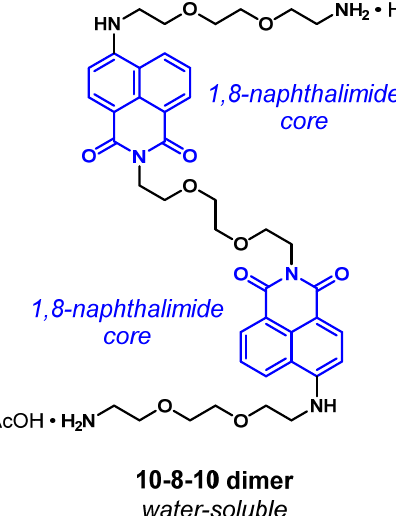
Figure 1. Structure of 10-8-10 Dimer.